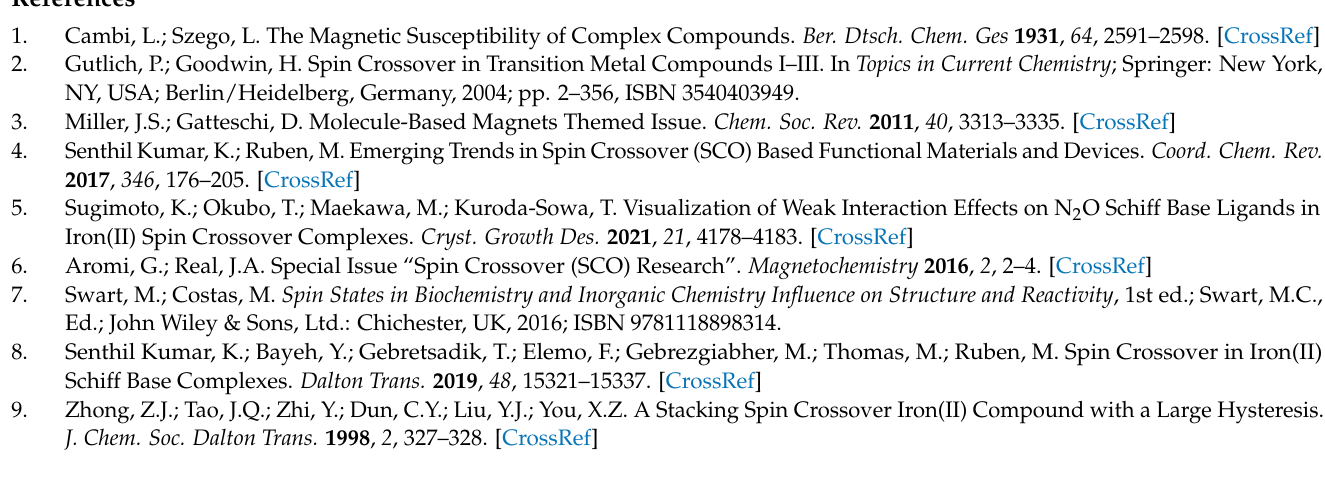
Figure S2: Projection of the π - π interaction through phenyl rings of 1 (a) along the bc plane and 2 (b) along the ab plane. ClO4-ions, solvents and hydrogen atoms have been omitted for clarity. Short intermolecular contacts and H-bonding 1 (c) and 2 (d) both in b-direction; Figure S3: (a) 1H NMR and (b) 13C NMR of L1; Figure S4: (a) 1H NMR and (b) 13C NMR of L2; Figure S5: (a) 1H NMR and (b) 13C NMR of 1; Figure S6: (a) 1H NMR and (b) 13C NMR of 2; Figure S7: ESI-MS molecular ion peaks of 1 (a) and 2 (b); Table S1: Experimental and computed 1H NMR shifts (in ppm vs. TMS) in free ligands L1, L2 and corresponding [Fe(L1)2]2+ and [Fe(L2)2]2+ complexes (all in CD3CN); Table S2: Experimental and computed 13C NMR shifts (in ppm vs. TMS) in free ligands L1, L2 and corresponding [Fe(L1)2]2+ and [Fe(L2)2]2+ complexes (all in CD3CN); Table S3: Coordination bond angles for 1 and 2 at 120